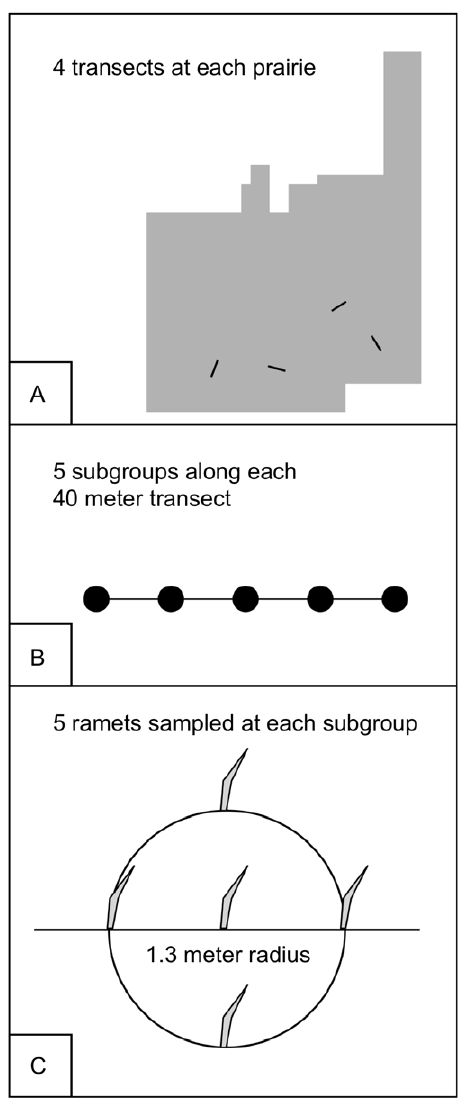
Figure 3. Sampling methodology at different scales. Each prairie (A) contained four transects. Each 40 m transect (B) contained a series of five subgroups. Five ramets were sampled at each subgroup (C).